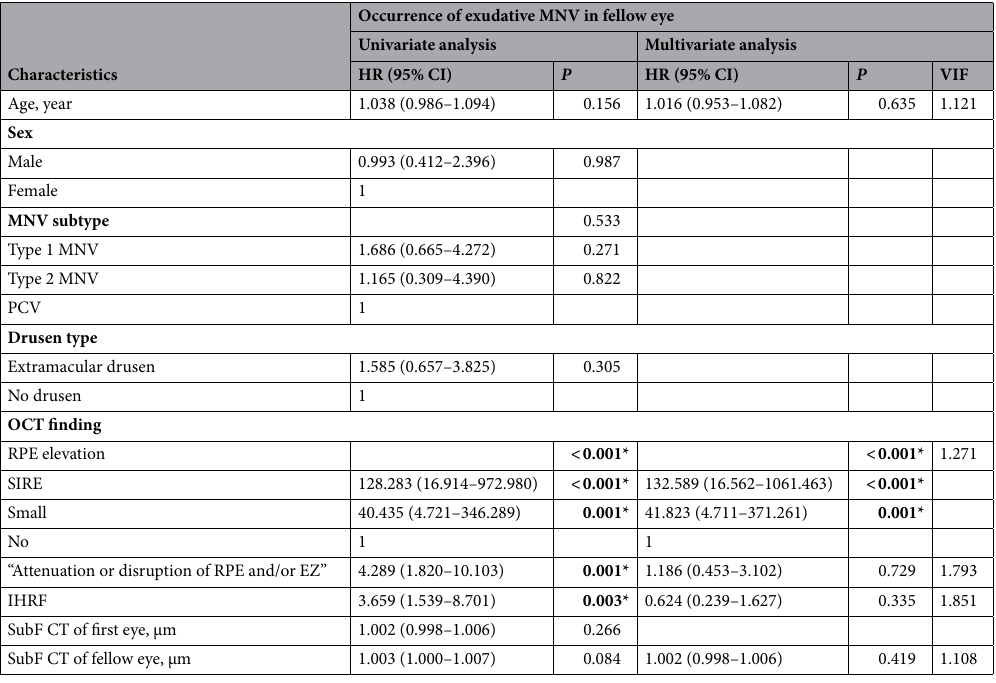
Table 4. Cox proportional hazard model using optical coherence tomography findings for occurrence of fellow eye exudative macular neovascularization in patients with unilateral exudative macular neovascularization and fellow eye without significant drusen. Significant values are in bold. MNV = Macular neovascularization; PCV = Polypoidal choroidal vasculopathy; OCT = Optical coherence tomography; RPE = Retinal pigment epithelium; SIRE = Shallow irregular RPE elevation; EZ = Ellipsoidal zone; IHRF = Intraretinal hyperreflective foci; SubF = Subfoveal; CT = Choroidal thickness; HR = Hazard ratio; CI = Confidence interval; VIF = Variance inflation factor. *Significantly